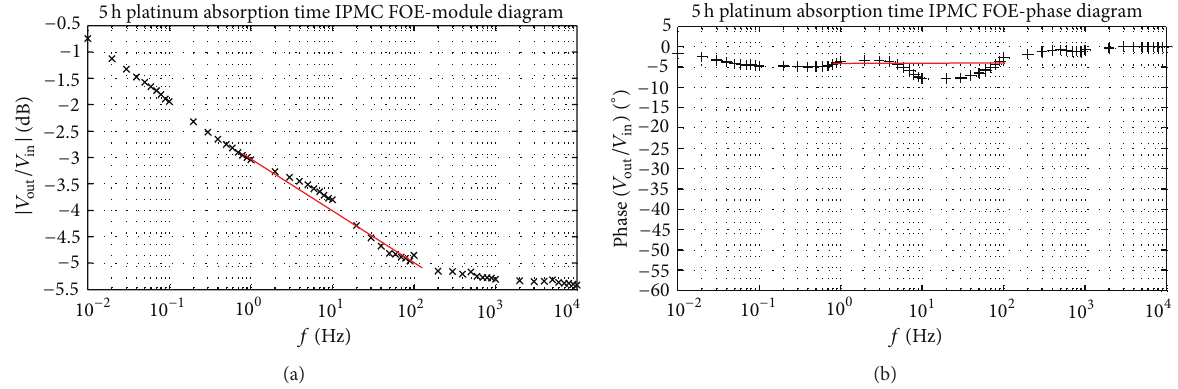
Figure 10: (a) Module and (b) phase diagrams of the ratio V out / V in in the complete experimental frequencies range: 10 mHz to 10kHz for the IPMC device at 5h absorption